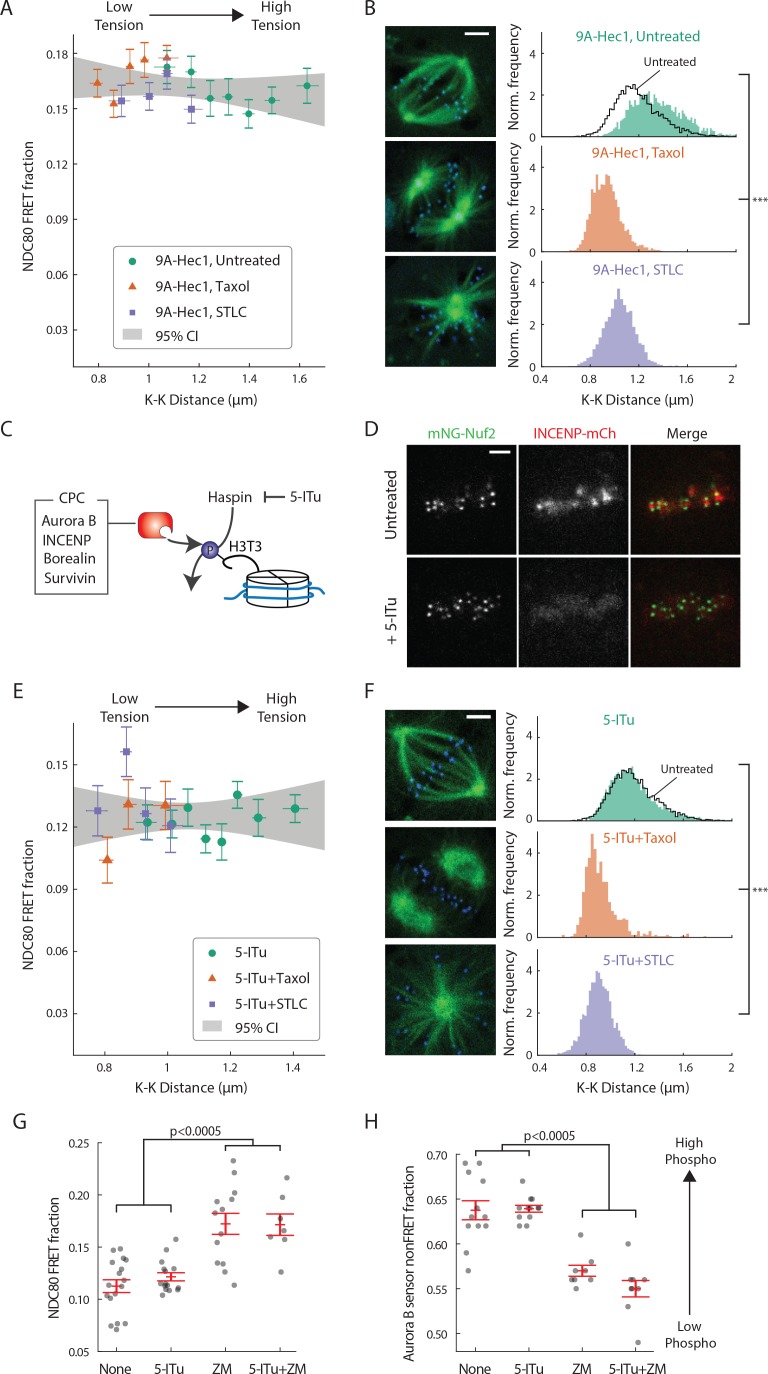
Haspin-dependent centromere-localized Aurora B is responsible for the tension dependency of NDC80-kMT binding.(A) NDC80 FRET fraction vs. K-K distance for 9A-Hec1-expressing cells with no drug treatment (green circle, n = 12 cells, 803 kinetochores/data point), with 10 μM taxol treatment (orange triangle, n = 9 cells, 1113 kinetochores/data point), or with 5 μM STLC treatment (purple square, n = 10 cells, 855 kinetochores/data point). For STLC data, only poleward-facing kinetochores are included (see Figure 5—figure supplement 1A for comparison between poleward-facing and anti-poleward-facing kinetochores). Data points are the mean, y-error bars the SEM, and the x-error bars the interquartile ranges within groups of kinetochores with similar K-K distances. Gray area is the 95% confidence interval for the linear fit to the combined data. (B) Histograms of K-K distances for the untreated 9A-Hec1 cells (top, green), untreated cells with endogenous Hec1 (top, black line), 9A-Hec1 cells treated with taxol (middle, orange), and 9A-Hec1 cells treated with STLC (bottom, purple). 3 μm scale bar in the cell images of mTurquoise2-NDC80 (blue) and beta-tubulin-TC-FlAsH (green). ***p<10−6 (Welch’s t-test). (C) Haspin kinase phosphorylates histone H3 at Thr3 (H3T3), which recruits the chromosome passenger complex (CPC, red) to centromeres. 5-Iodotubercidin (5-ITu) inhibits haspin kinase, thereby displacing Aurora B from centromeres. (D) Spinning-disk confocal microscopy images of cells expressing mNeonGreen-Nuf2 (green) and INCENP-mCherry (red) before (top) and after (bottom) haspin inhibition by 10 μM 5-ITu treatment. 3 μm scale bar. (E) NDC80 FRET fraction vs. K-K distance for cells treated with 10 μM 5-ITu (green circle, n = 15 cells, 1170 kinetochores/data point), for cells treated with both 10 μM 5-ITu and 10 μM taxol (orange triangle, n = 3 cells, 359 kinetochores/data point), and for cells treated with 10 μM 5-ITu and 5 μM STLC (purple square, n = 12 cells, 564 kinetochores/data point). For 5-ITu + STLC data, only poleward-facing kinetochores are included (see Figure 5—figure supplement 1B for comparison between poleward-facing and anti-poleward-facing kinetochores). Data points are the mean, y-error bars the SEM, and the x-error bars the interquartile ranges within groups of kinetochores with similar K-K distances. Gray area is the 95% confidence interval for the linear fit to the combined data. (F) Histograms of K-K distances for the 5-ITu-treated (top, green), untreated (top, black line), 5-ITu + taxol treated (middle, orange), and 5-ITu + STLC treated cells (bottom, purple). 3 μm scale bar in the cell images of mTurquoise2-NDC80 (blue) and beta-tubulin-TC-FlAsH (green). ***p<10−6 (Welch’s t-test). (G) NDC80 FRET fraction and (H) the non-FRET fraction of Nuf2-targeted Aurora B FRET sensor (proxy for Aurora B activity at NDC80) for different drug treatments. Each data point (gray circle) corresponds to an individual cell, and the error bar (red) shows the mean and SEM. P-values from two-sided Welch’s t-test. Data points and source FLIM data are available in Figure 5-Data (Yoo et al., 2018).